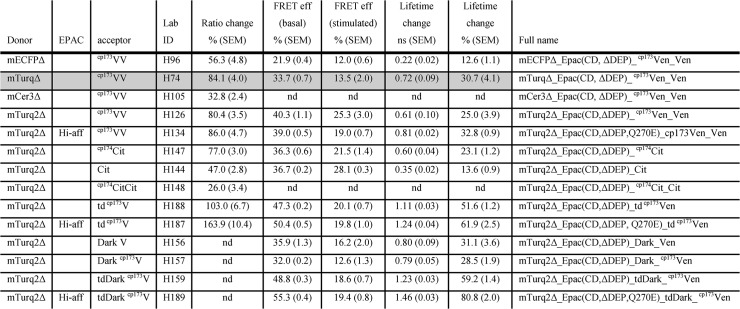
Summary of FRET changes of the constructs mentioned in this study.Mentioned are construct details (column 1–3), unique Lab ID (column 4), % ratio change (expressed as cAMP-induced change from an initial baseline ratio of 1, column 5) with its Standard Error of Mean, FRET efficiency E in rest (column 6) with SEM, E after saturation of the sensor with IBMX and Forskolin with SEM (column 7), absolute change of lifetime in ns with SEM (column 8) and % change in lifetime with SEM (column 9). Column 10 contains the fully descriptive name. As mentioned in the main text, we will from now on for brevity name the sensors "Epac-SLabID", for example, Epac-SH96 for mECFPΔ_Epac(CD, ΔDEP)_cp173Ven_Ven.In gray is the reference construct Epac-SH74. Abbreviations: nd, not determined; mCer3, monomeric Cerulean 3; mECFP, monomeric enhanced CFP; mTurq, monomeric Turquoise fluorescent protein; Hi-aff, High-affinity (Q270E mutant); cp173V, circular permutation of the fluorescent protein Venus(etc); td cp173V (etc), tandem of two cp173V fluorophores; cp173VV, tandem of cpVenus and Venus; CD, catalytically dead mutant (T781A & F782A amino acids of the Epac1 wild type protein); ΔDEP, deletion of the DEP domain to prevent membrane localization. Note that unlike Venus, Citrine contained the A206K monomerizing mutation. FRET efficiency E was calculated as E = 1-τDonorAcceptor/τDonor using τDonor = 4.10 ns for mTurquoise2 and 3.70 ns for mTurquoise1.